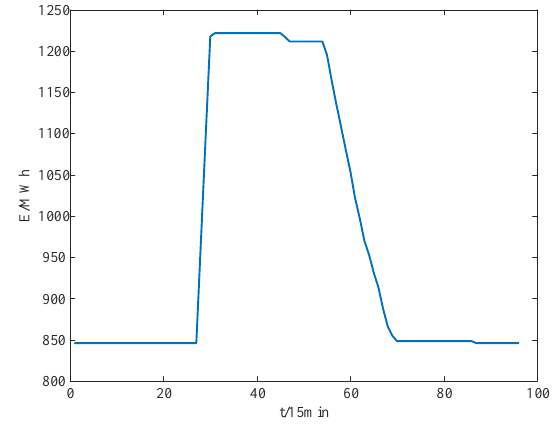
Figure 12. Stored energy schedule in the upper reservoir of PSH unit.